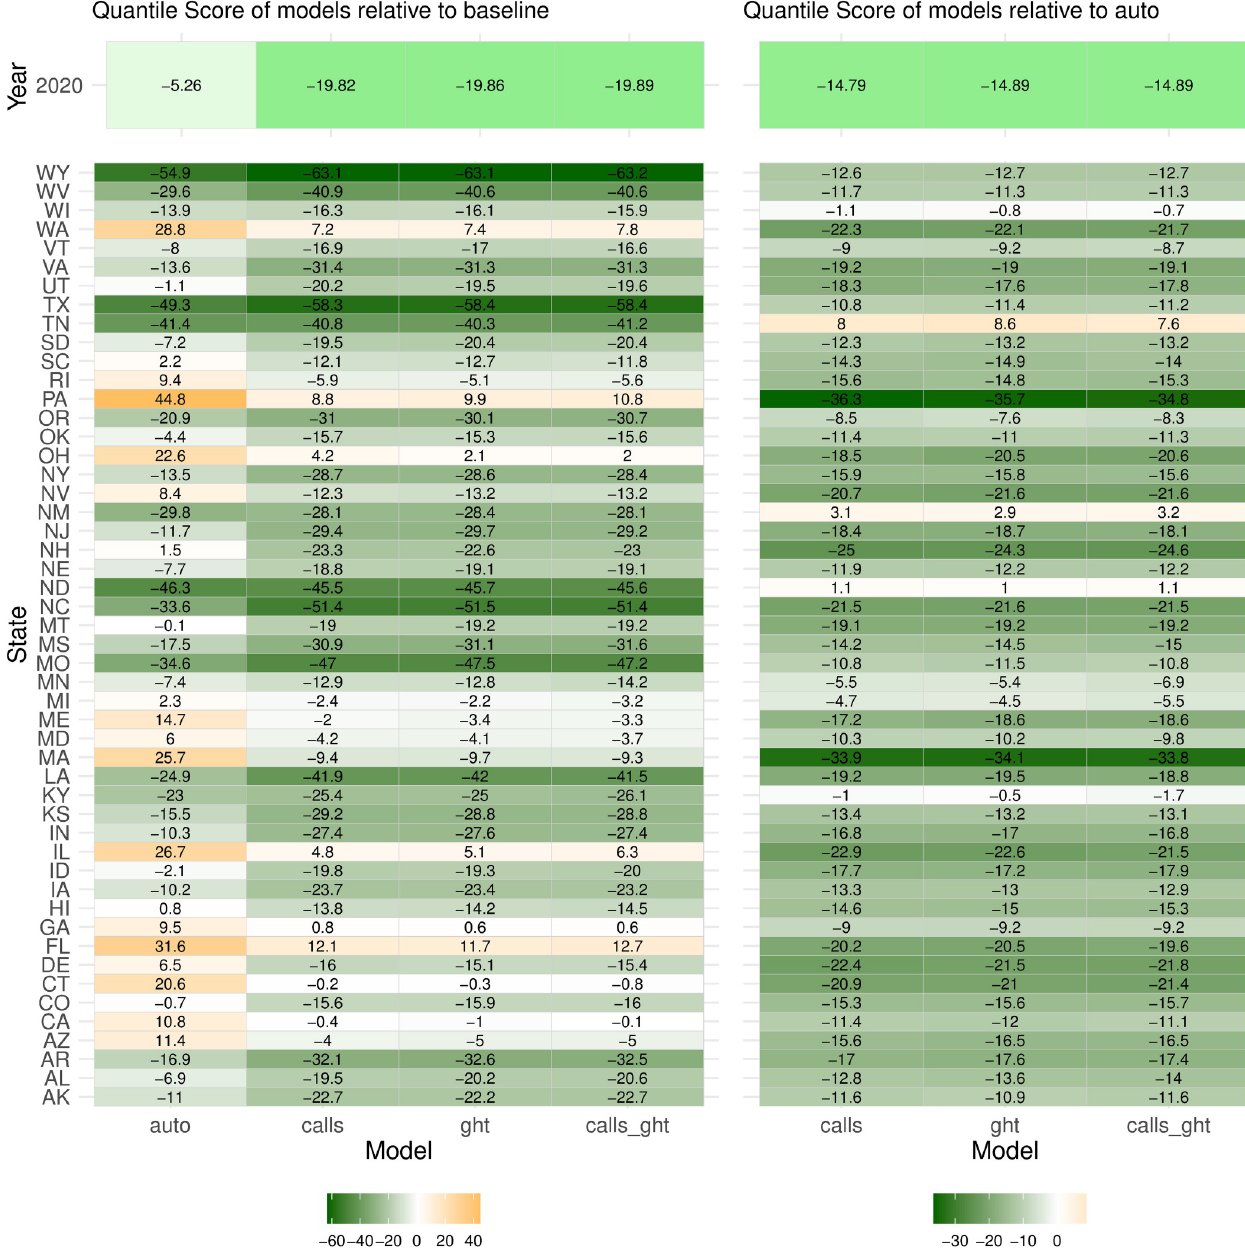
Fig 6. Quantile scores of forecasts from augmented models relative to baseline model (left) and relative to auto model (right), by state, during the test period (January 2020 – December 2020). Note that forecasts generated for the latter half of the year cannot be fully evaluated until mortality data for 2021 are available (for example, of forecasts generated at August 2020, 5-month ahead (Jan 2021) and 6-month ahead (Feb 2021) could not be evaluated).